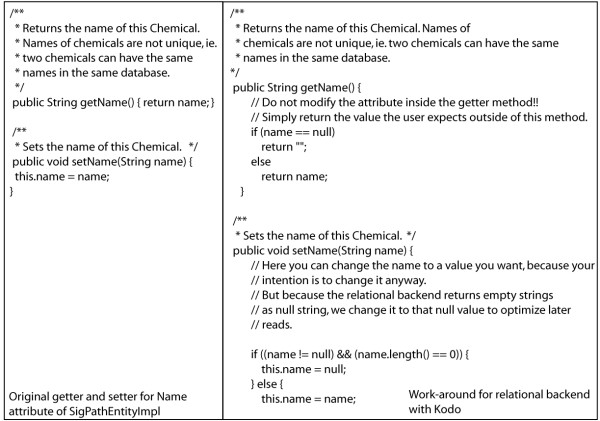
Work around for classes that have String getter and setters, when empty strings can be made persistent.